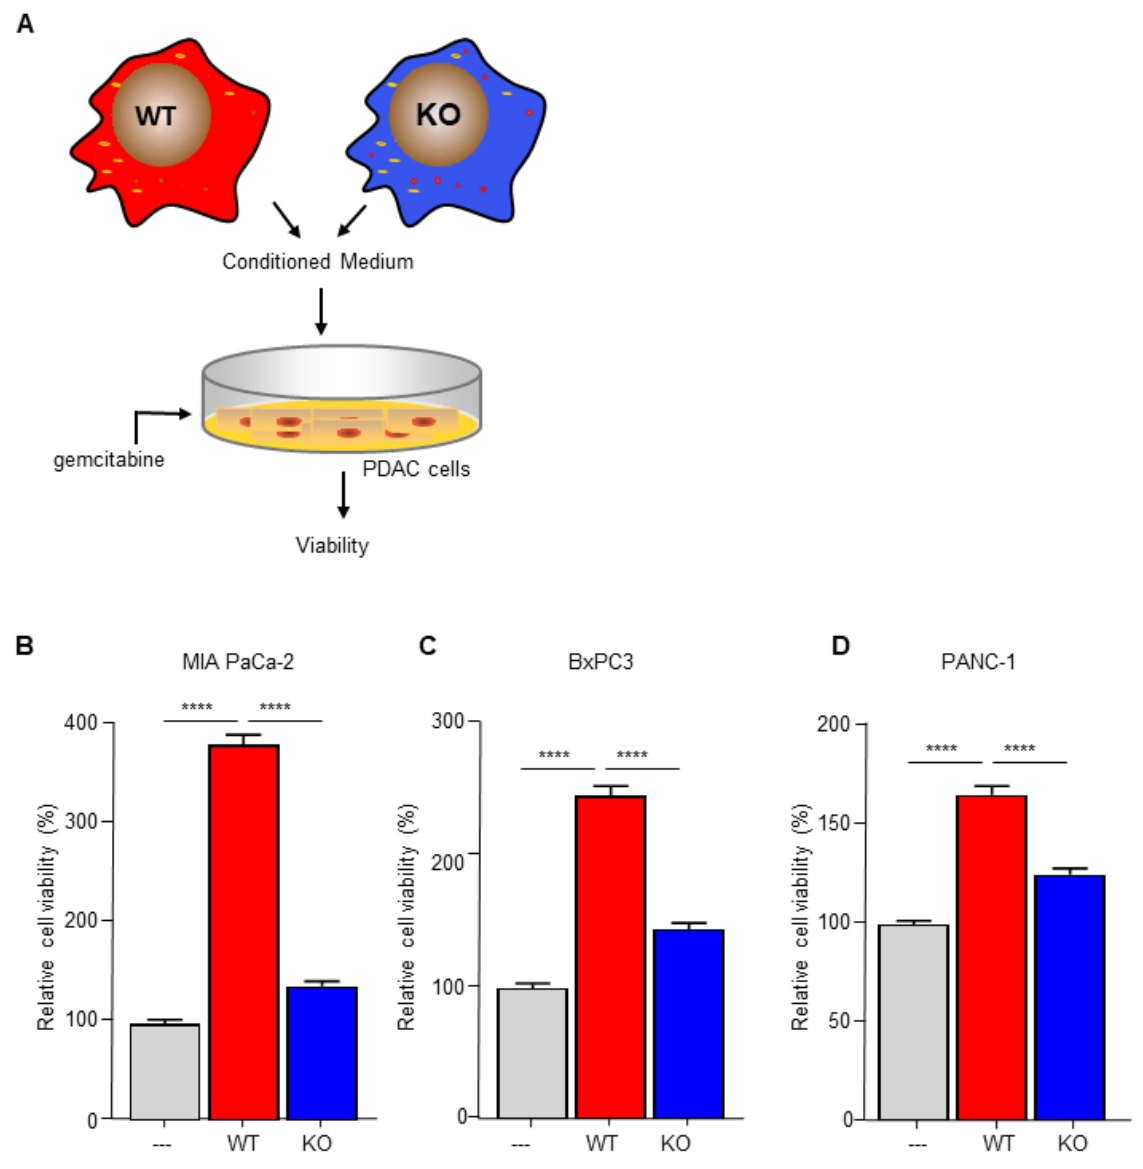
Figure 1. Macrophage C/EBP δ drives gemcitabine resistance of pancreatic cancer cells. ( A ) Schematic overview of the experimental set up. ( B–D ) Viability of Mia PaCa-2 (B), BxPc3 ( C ) and PANC-1 ( D ) pancreatic cancer cells in control medium (---), conditioned medium obtained from wild type macrophages (WT) and conditioned medium obtained from C/EBP δ -deficient macrophages (KO) in the presence of gemcitabine. Shown is the mean ± SEM of two to three independent experiments performed in sixplo. **** p < 0.0001.